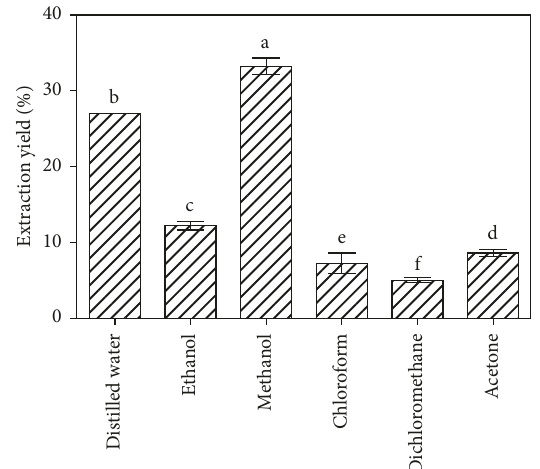
Figure 1: Effect of different solvents on extraction yield. Vertical bars illustrate the standard deviation ( n characters represent significant difference at p multiple range test.